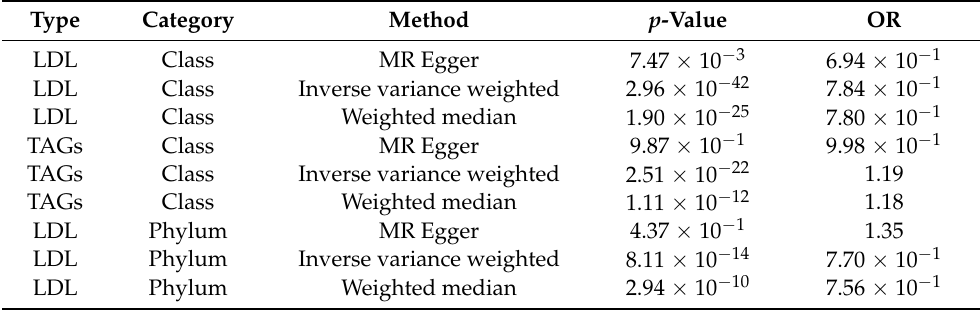
Table 5. Mendelian randomization results of Actinobacteria and blood lipid levels.